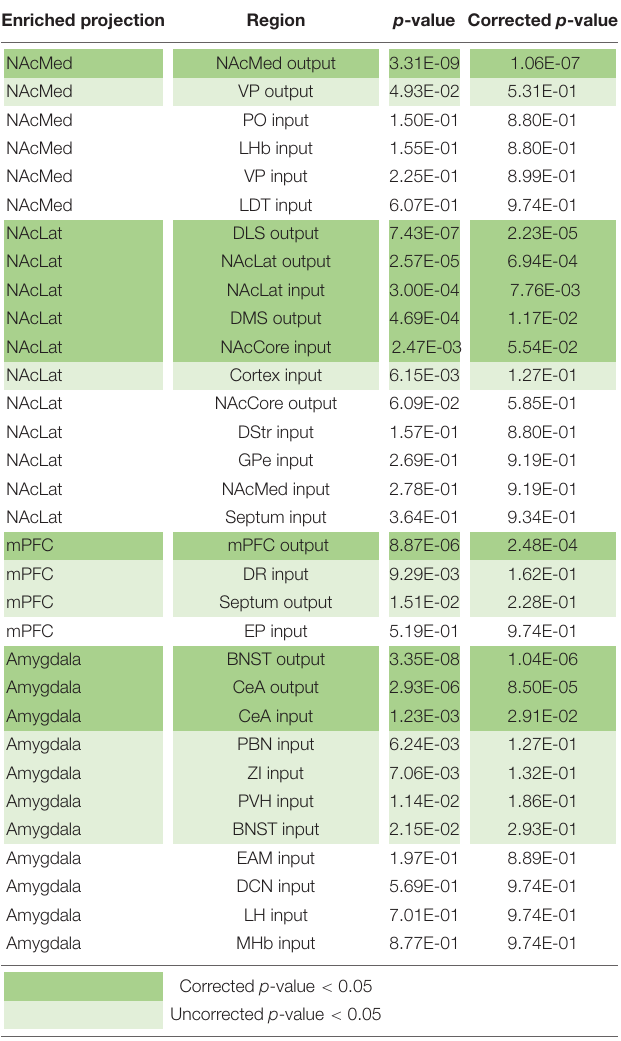
TABLE 2 | Sample mean comparison tests for input and output z-scores. TABLE 3 | Logistic regression scores predicting projection conditions from starter cell location and principal